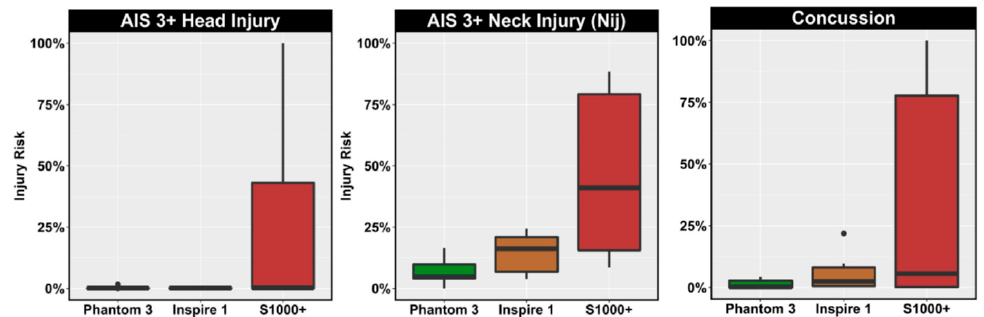
Figure 10. AIS 3+ head and neck injury risk and summary of concussion risk by UAV model. Head and neck injury risk as well as the risk of concussion were found to increase with increasing UAV mass, used with permission under Creative Commons Attribution 4.0 International License